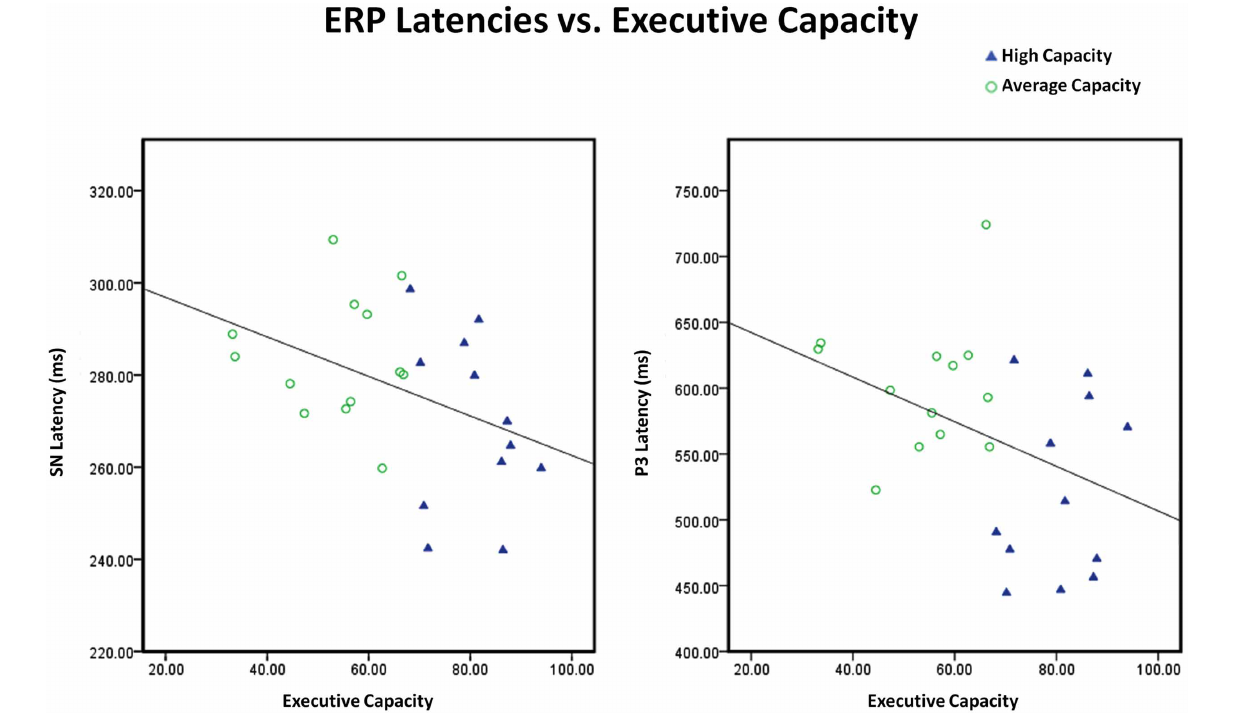
FIGURE 10 | Scatter plots illustrating that the inverse relationships between executive capacity and both SN and P3 latencies were continuous. Executive capacity = composite (mean percentile) score on tests of executive function. Note that there are different scales for SN latency and P3